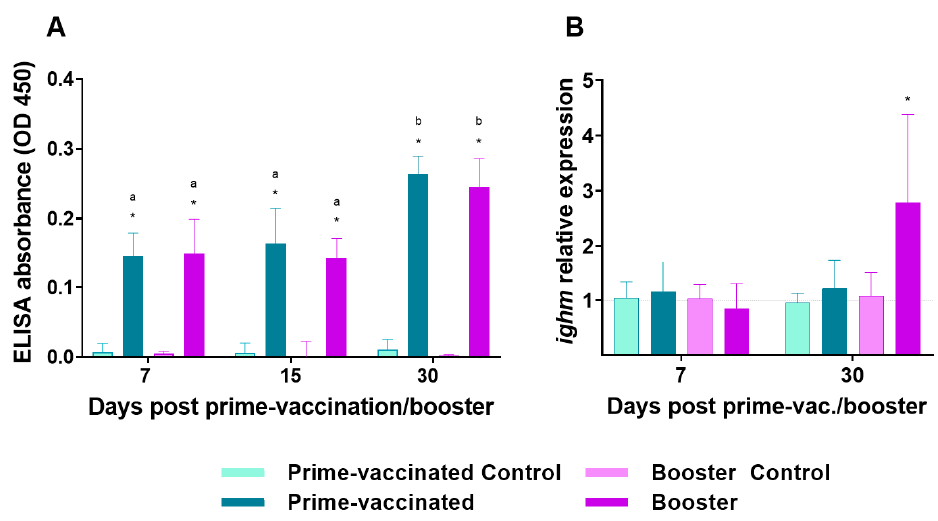
Figure 3. IgM levels in the serum ( A ) and transcription of ighm ( B ) in the head-kidney of prime- vaccinated and re-immunized fish at 7-, 15- and 30-days post vaccination/re-immunization. Data represent the mean ± standard deviation (n = 6 fish/group and time). Asterisks represent statistical differences between control and prime-vaccinated/booster groups ( p < 0.05). Significant differences between groups are indicated by different lower letters over bars ( p < 0.05).